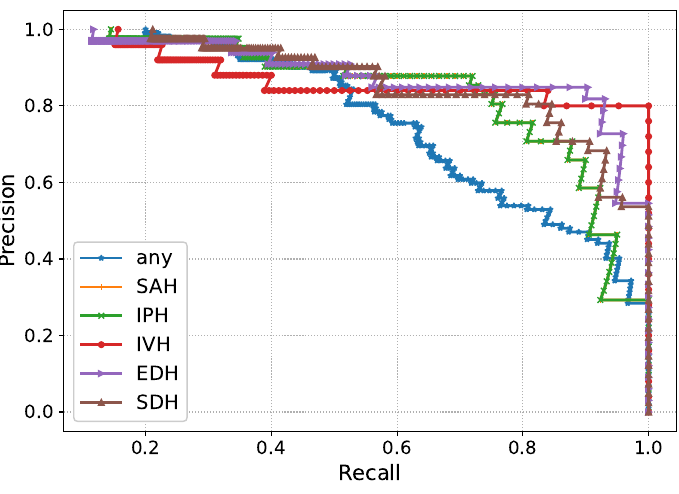
Figure 13. AUC-based performance of the proposed solution.